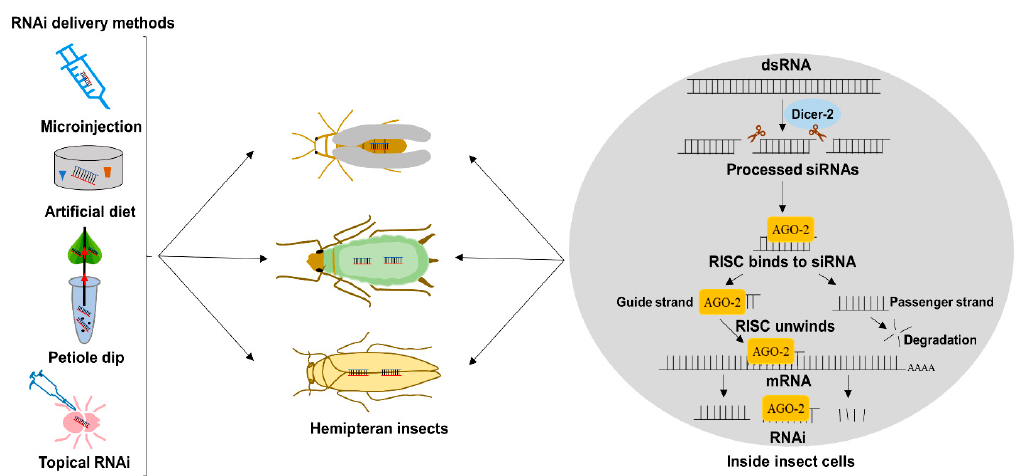
Figure 1. Schematic of RNA interference (RNAi) delivery strategies and RNAi mechanism in insects. In functional genomic studies in Hemiptera, dsRNA can be delivered by injection, diet feeding, petiole dipping and by topical application onto the target insect. Once the dsRNA is entered into the insect cell, dicer-2 recognises and cleave the dsRNA into siRNAs (21–24 nt). The siRNAs are then loaded in the RNA-induced silencing complex (RISC) that guides sequence-dependant degradation or translational inhibition of homologous mRNAs, resulting in RNAi-mediated silencing of the target gene.